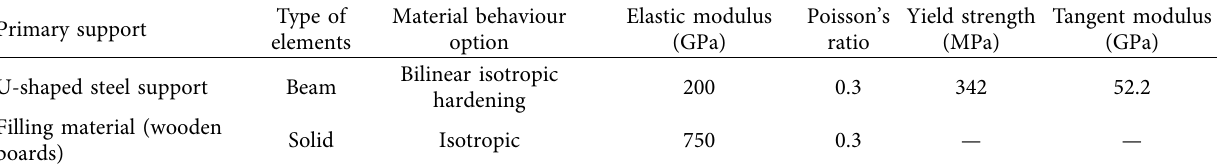
Table 3: Properties of support elements used in the